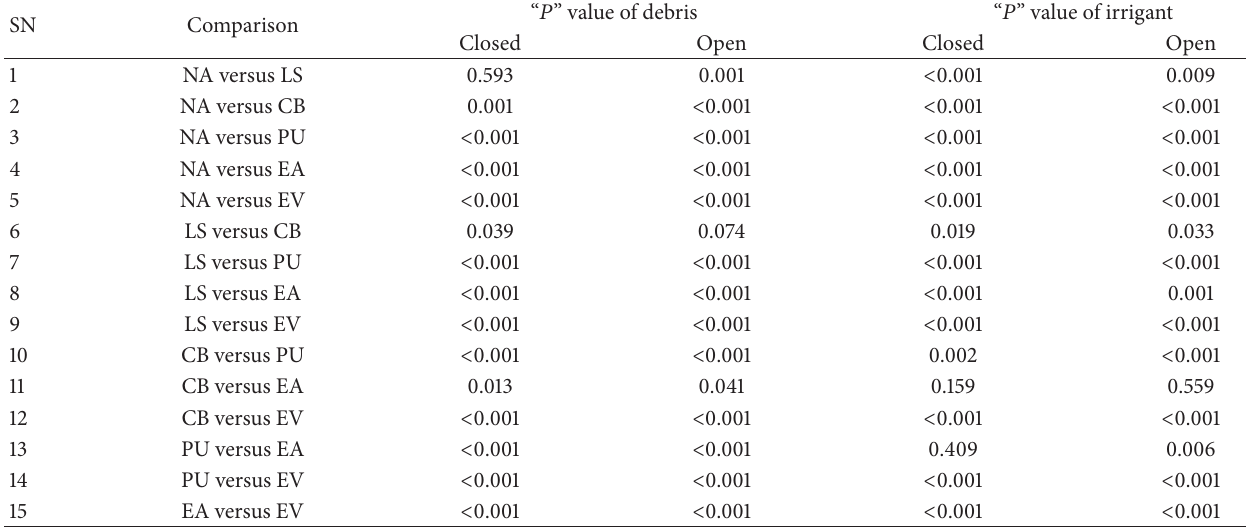
Table 2: Comparison of extruded debris and irrigant between open and close chamber groups (Tukey HSD test). SN